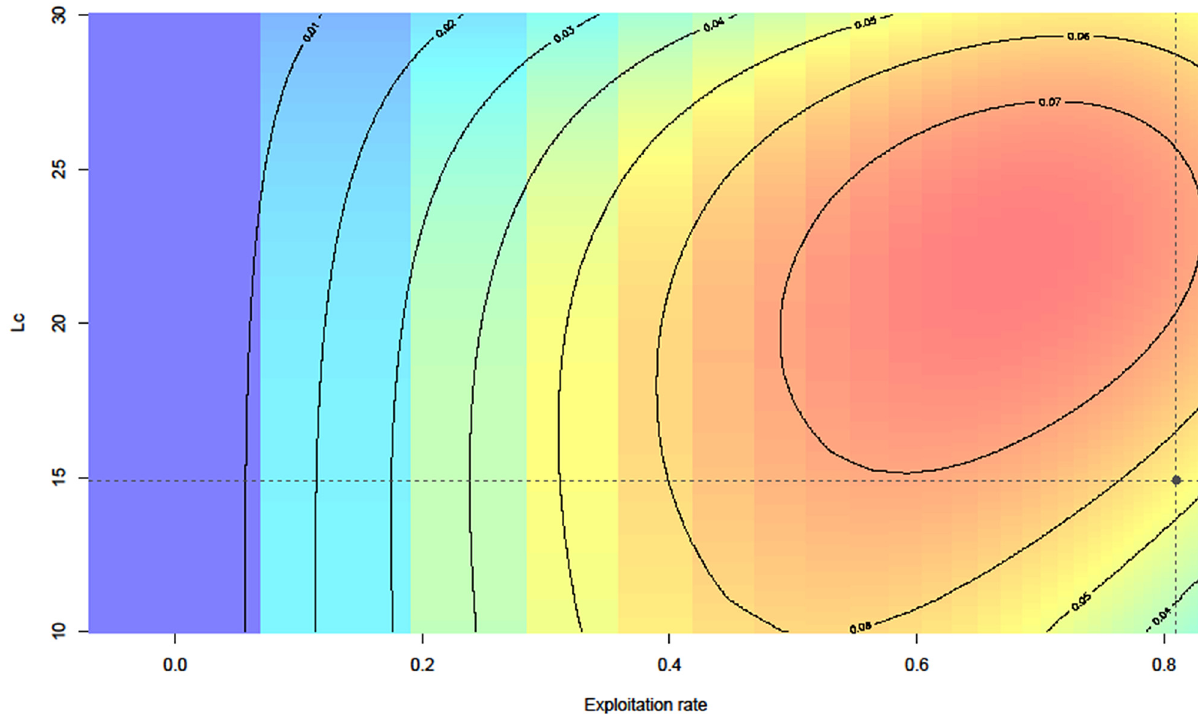
Fig. 7. Impact of different exploitation rates and L c values on the yield per recruit of S. undosquamis . The x-axis displays the exploitation rate (F/ Z) of the fully-exploited length class(es).